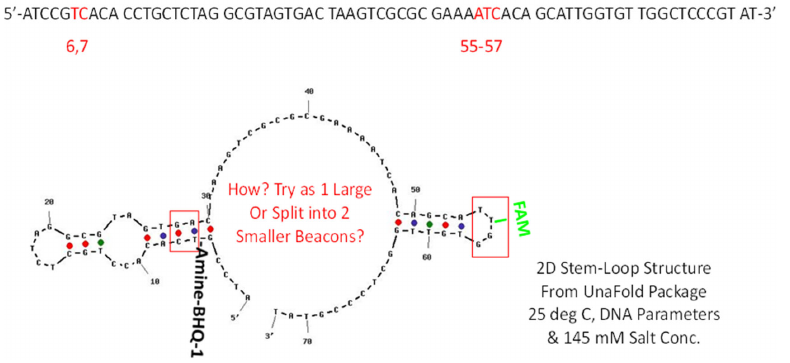
Figure 6. A 2D aptamer model generated by UnaFold showing the distal parts of the aptamer that appear to come together around KDO to achieve tight binding as shown in Figures 4 and 5. Unfortunately, labeling these areas with fluorescein (FAM) and BHQ ‐ 1 still did not lead to a useful beacon.